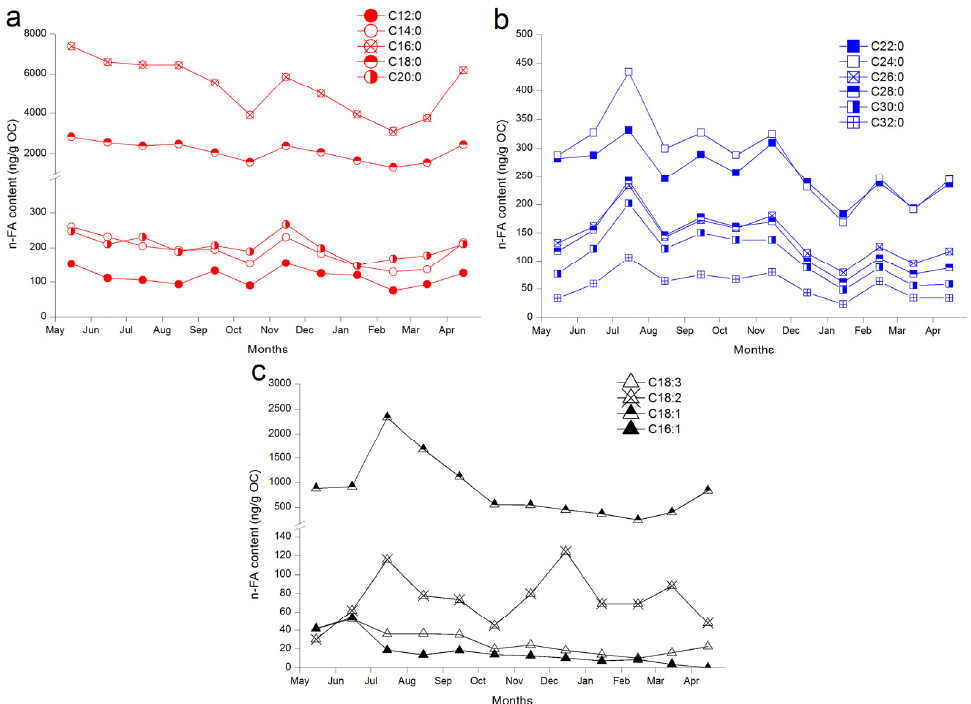
Figure 10. Temporal variations in individual n -FA TOC normalized contents of ambient air aerosols in south coastal Xiamen. ( a ) short-chain saturated homologs; ( b ) long-chain saturated homologs; and ( c ) unsaturated homologs.